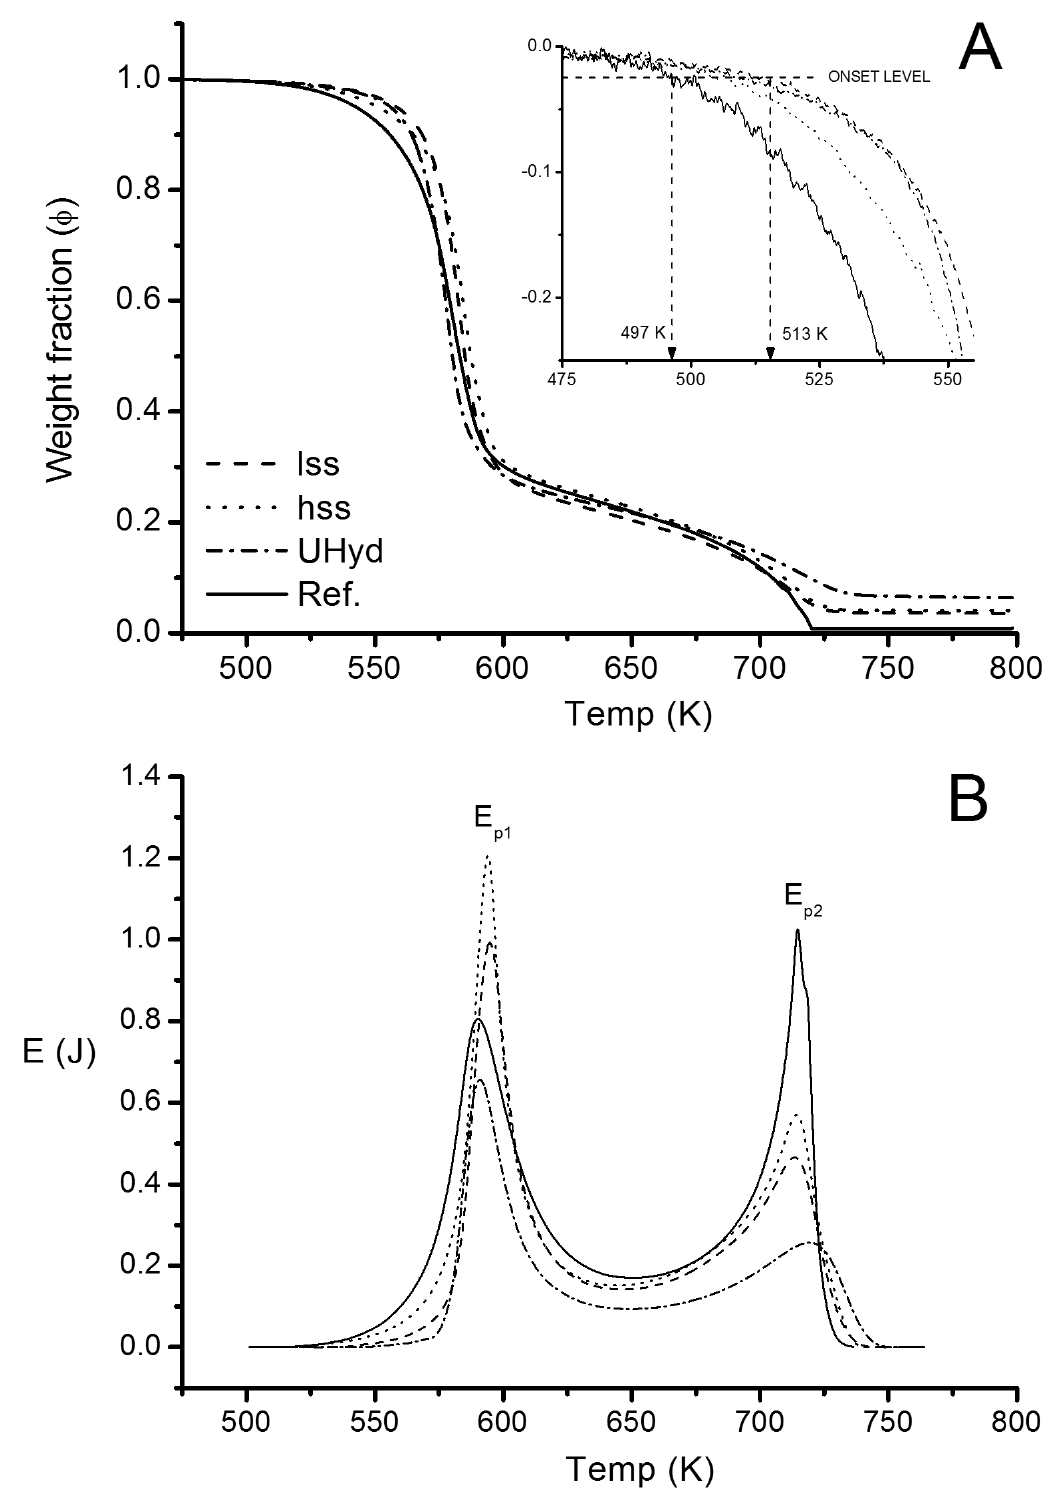
Figure 7. ( A ) The thermograms and onset temperature analysis (inset) for oxidative combustion of fully bleached Kraft pulp fibres from Pine with LDH ( lss , hss , Uhyd ) and without (Reference) ( A ); and released energy at a given temperature ( B ) are